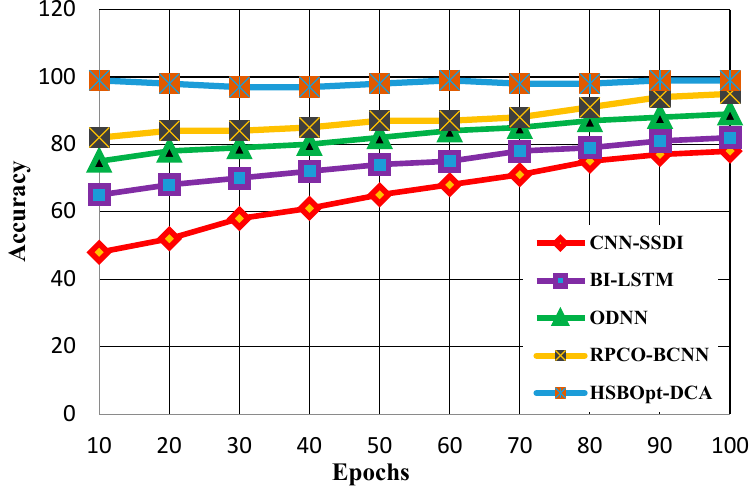
Figure 4. Accuracy calculation with 100 epochs.